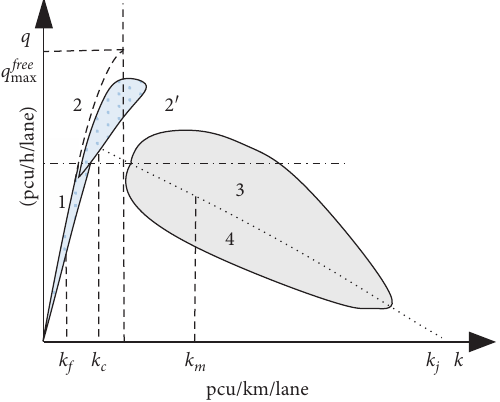
Figure 3: State division of traffic flow.